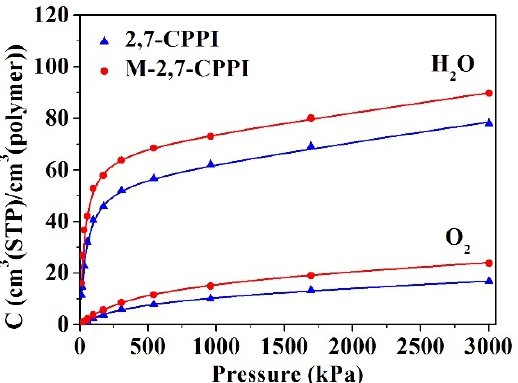
Figure 12. The adsorption isotherms of O 2 and H 2 O in M-2,7-CPPI and 2,7-CPPI.